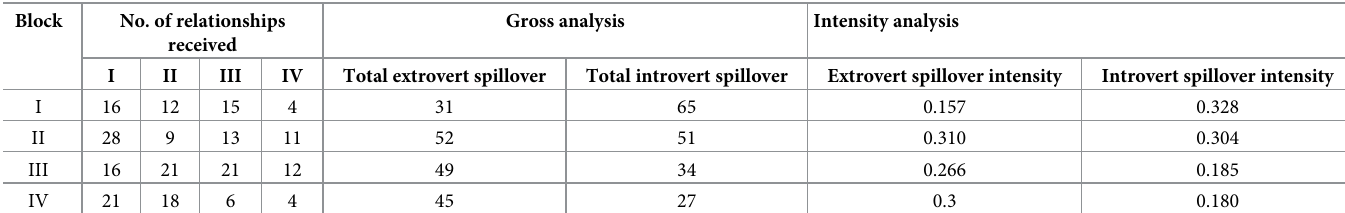
Table 5. Relationships between blocks: Gross analysis and intensity analysis.